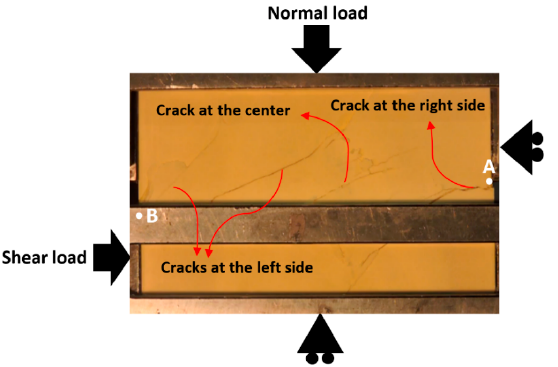
Figure 16. Crack initiation and propagation zones in J&Br specimens under direct shear test con-